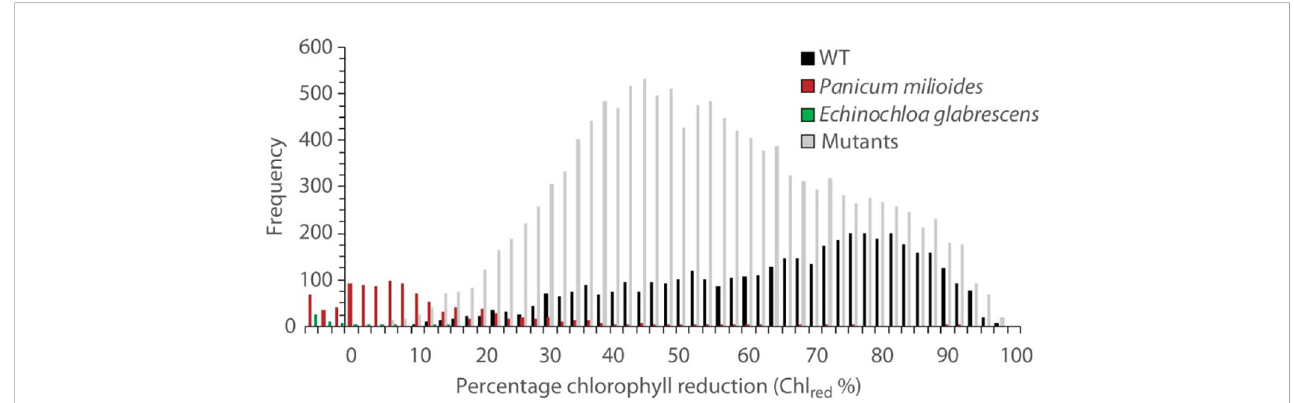
FIGURE 2 Frequency of chlorophyll reduction percentage (Chl red %) in WT IR64 (black), the C3/C4 intermediate Panicum milioides (red), the C4 Echinochloa glabrescens (green) and the mutant rice population (grey). In total, 4261, 1018, 54 and 13,016 seedlings were screened before and after low CO2 treatment for WT, P. milioides , E. glabrescens and the mutants, respectively.